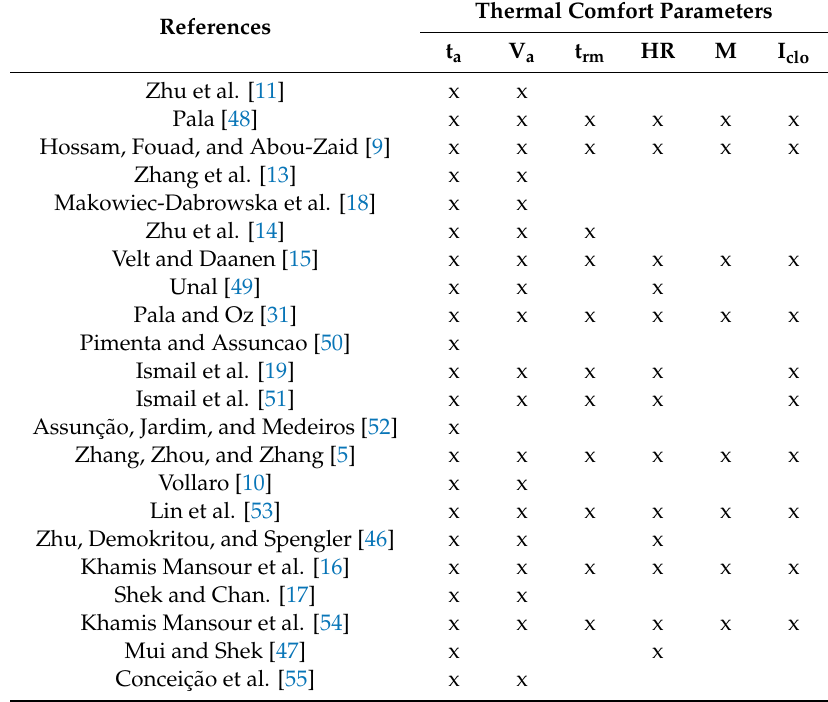
Table 8. Thermal comfort parameters considered in thermal comfort studies in bus